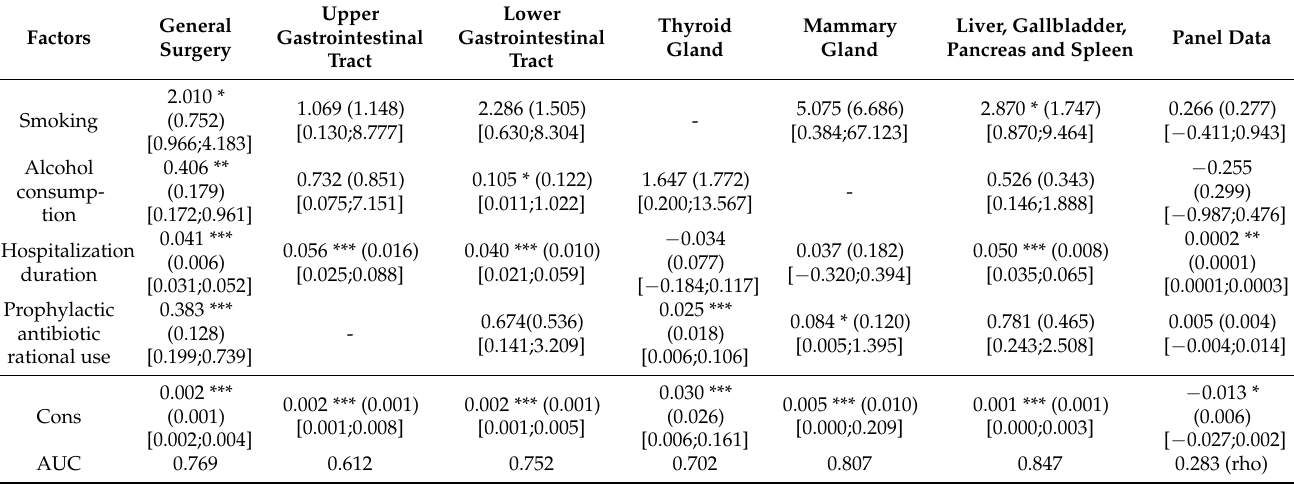
Table 3. Logit model and panel data analyses of perioperative prophylactic antibiotic rational use in the general surgery department and surgical-site